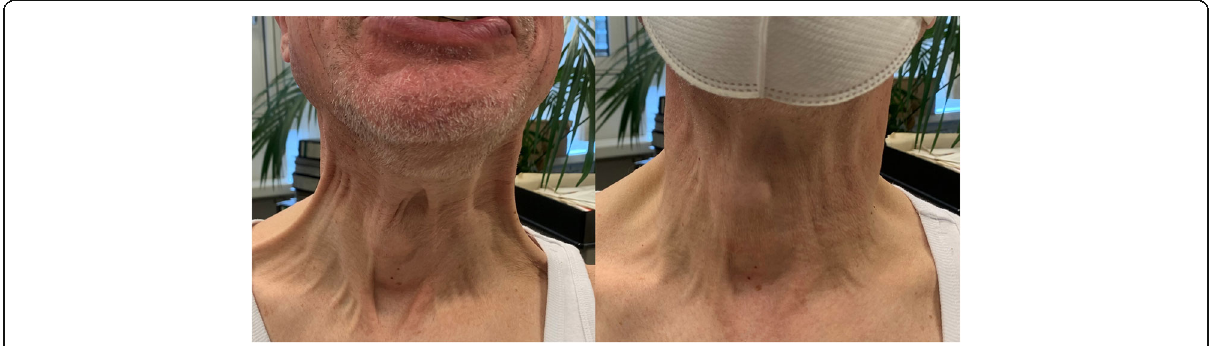
Fig. 1 Patient with permanent complex orofacial dystonia with severe platysmal involvement before (left) and promptly after mask application: platysmal activity decreases markedly (right). A sensory trick existed in the patient: without the mask he was able to similarly ameliorate the dystonia by touching his laryngeal